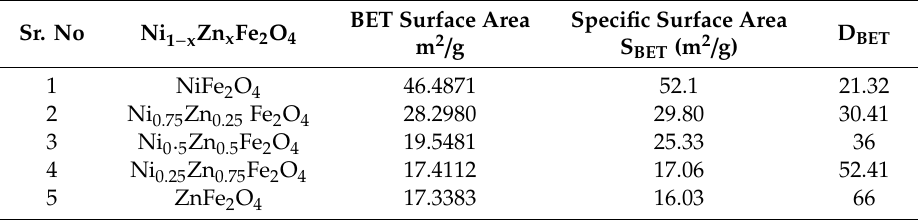
Table 3. The surface area analysis of nickel zinc